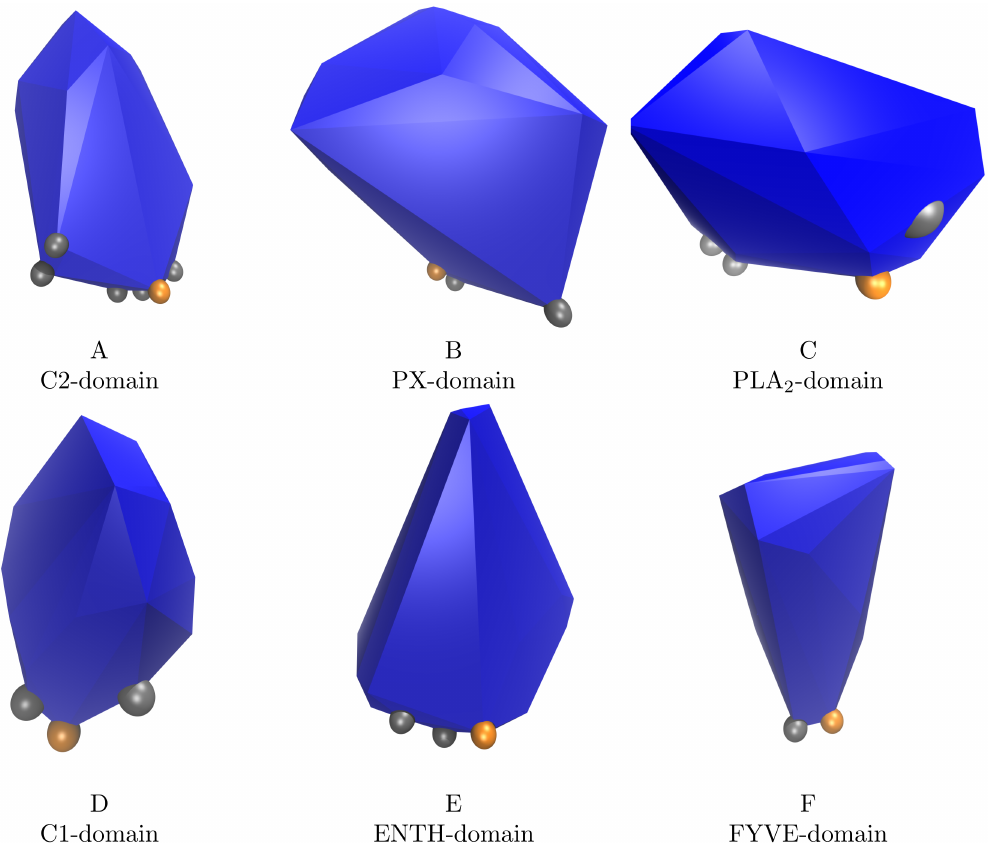
Fig 6. Protruding hydrophobes are found on the membrane binding sites of well known membrane binding domains. The figure shows the convex hull (in blue) of the C α and C β -atoms of selected peripheral membrane binding domains. The C β -atoms of ‘the Likely Inserted Hydrophobe’ are shown as orange spheres and C β -atoms of experimentally identified membrane-binding residues as gray spheres. The Likely Inserted Hydrophobe is an amino acid that has been experimentally verified to be a membrane binding residue for A, B, D and F. For C and E the Likely Inserted Hydrophobe is located in the same area as the residues identified by experiments. A : C2 domain of human phospholipase A2 (PDBID: 1RLW [18]); B : PX domain of P40PHOX (PDBID: 1H6H [19]); C : snake phospholipase A2 (PDBID: 1POA [20]); D : C1 domain of protein kinase C δ (PDBID: 1PTR [21]); E : Epsin ENTH domain (PDBID: 1H0A [14]); F : FYVE domain of yeast vacuolar protein sorting-associated protein 27 (PDBID: 1VFY